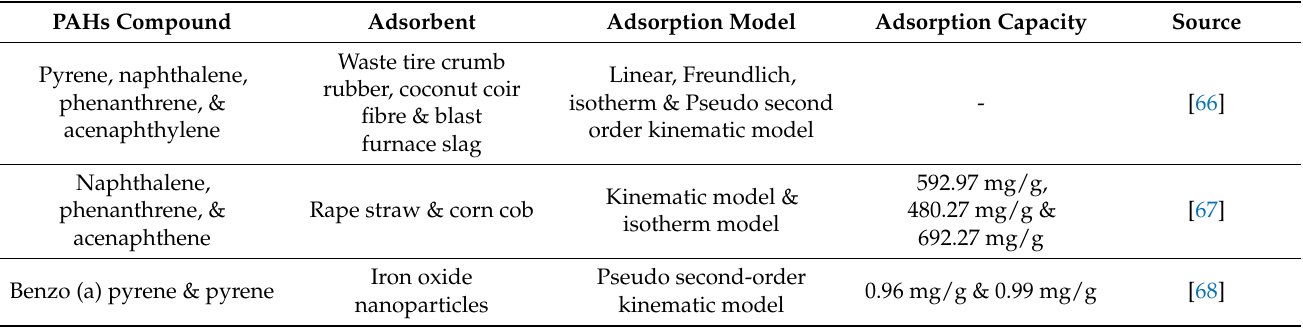
Table 4. Capacity for adsorption for removal of PAHs from water